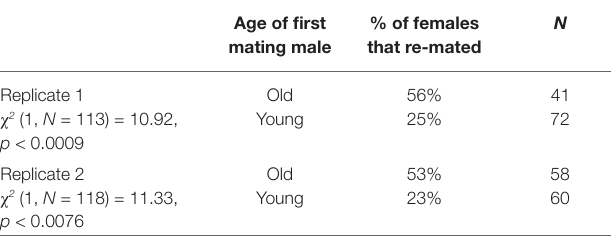
TABLE 1 | Female re-mating incidence is influenced by male age in Aedes aegypti.